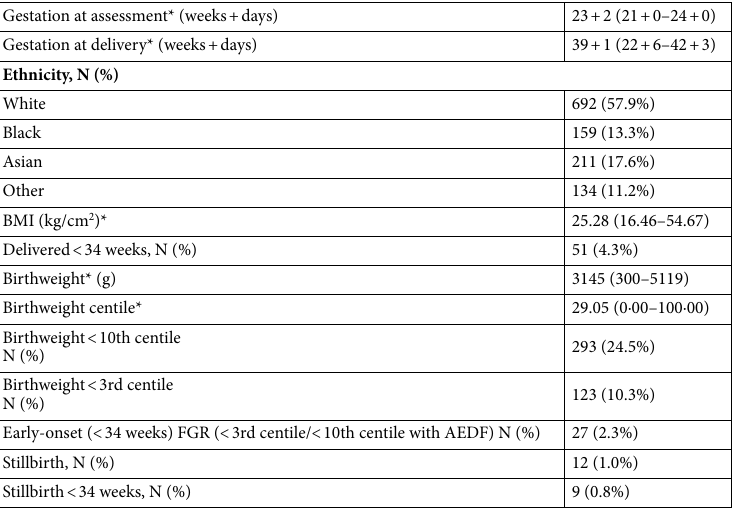
Table 1. General characteristics of the study group (n = 1196). BMI body mass index, FGR fetal growth restriction, AEDF absent end-diastolic flow. *Median (range) quoted for continuous non-parametric data.